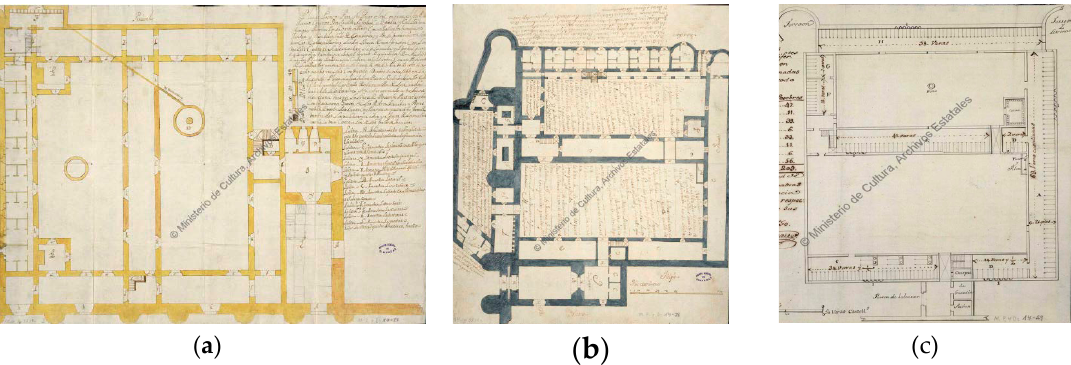
Figure 2. Different historical sources employed: ( a ) Juan Gómez Parral, 1749 (AGS. MPD. 14-027); ( b ) Juan Gómez Parral, 1749 (AGS. MPD, 14, 028); ( c ) Pedro Moreau, 1750 (AGS. MPD, 14, 029). Source: National Archive of Simancas (Spain). Adapted from [1].